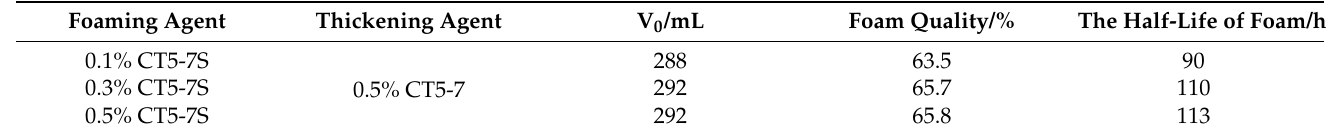
Table 6. The half-life of foam in gel fracturing fluid with different dosages of CT5-7S.